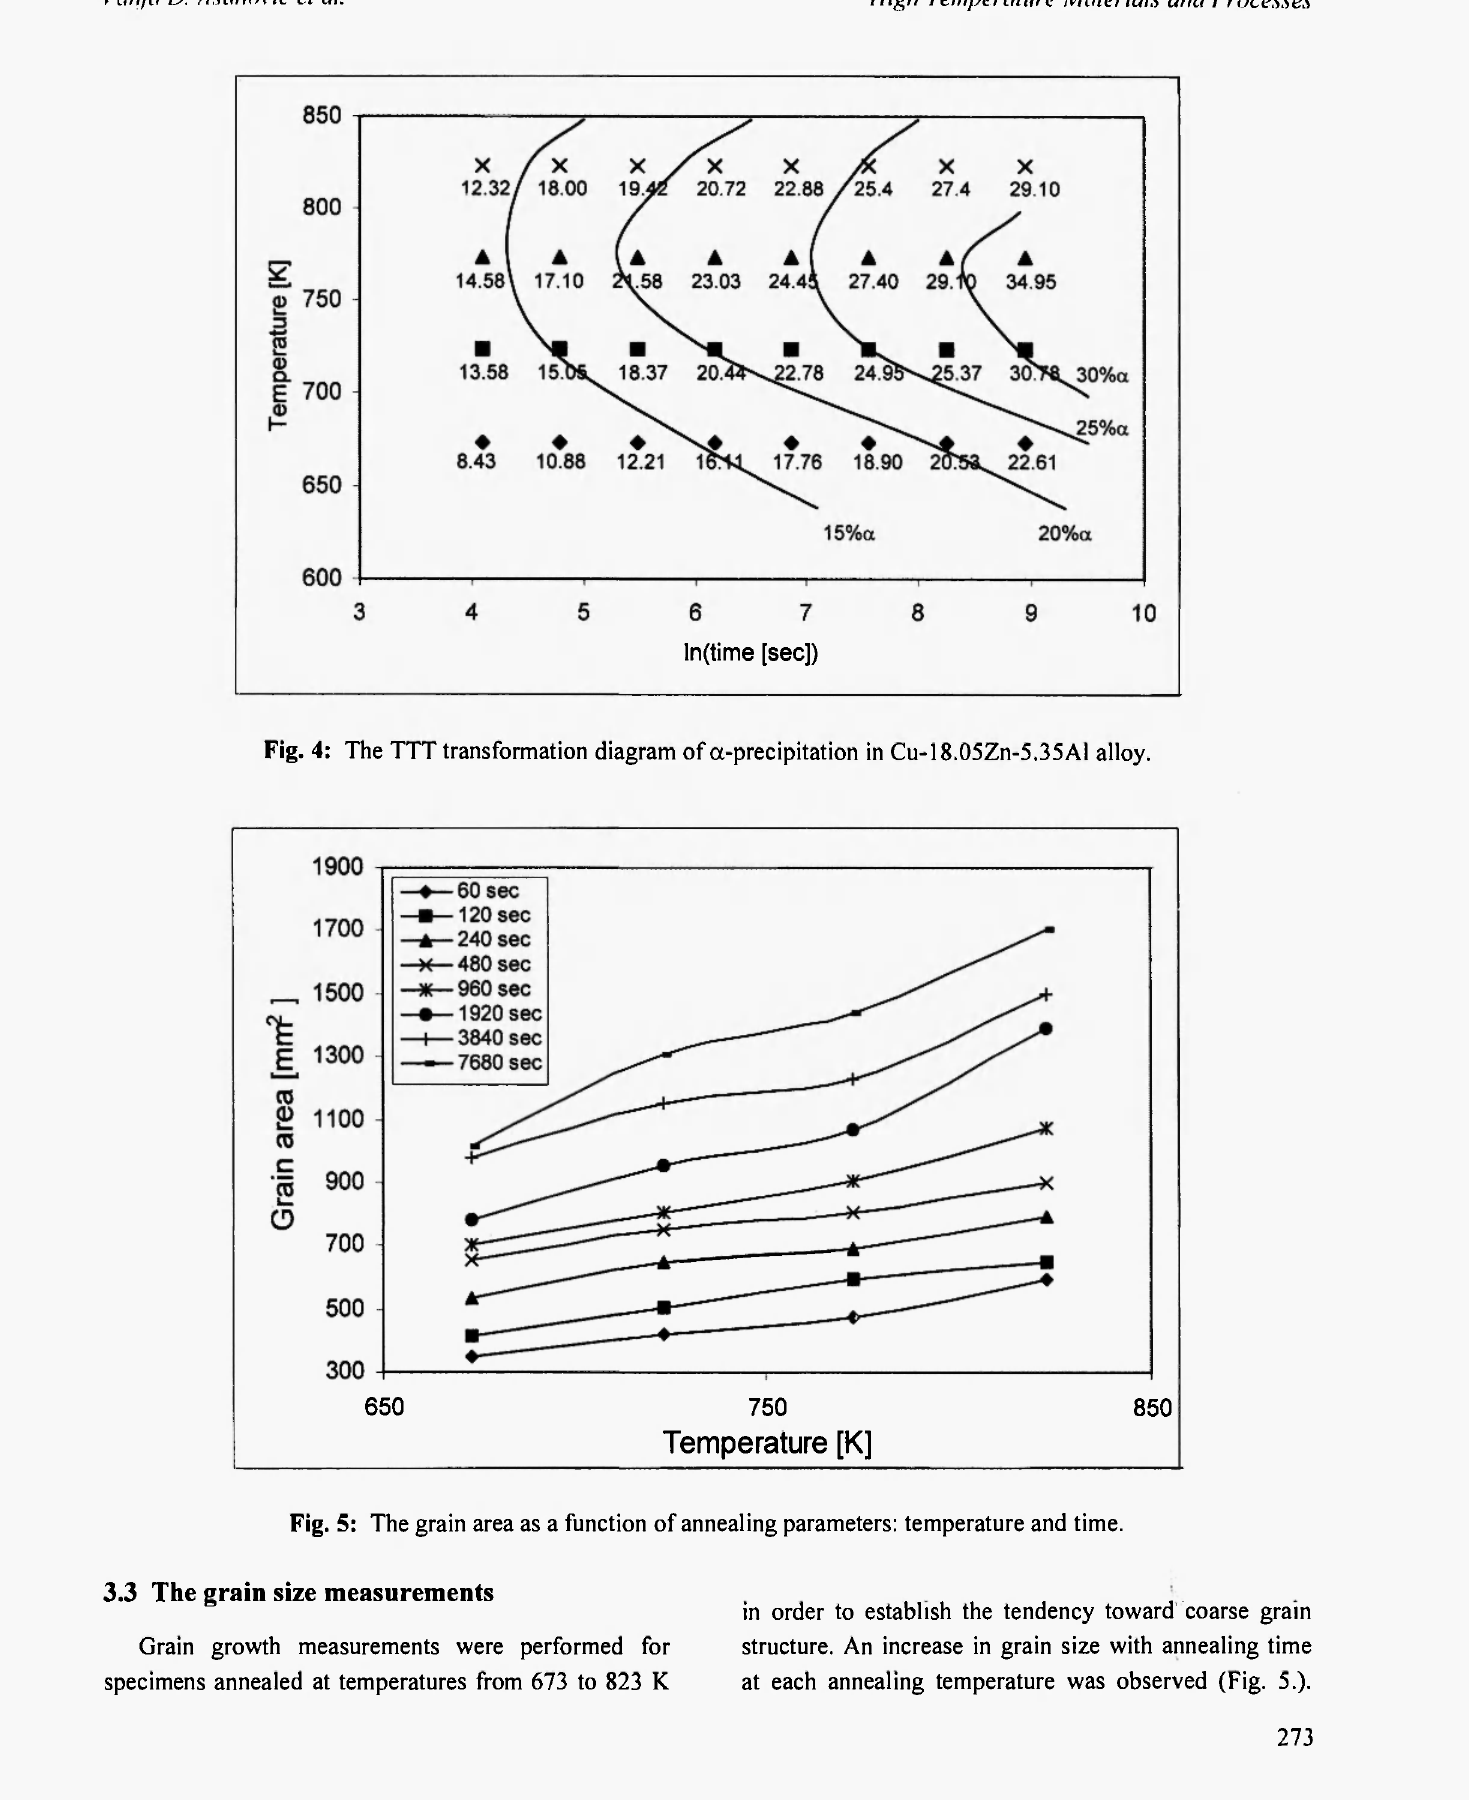
Fig. 5: The grain area as a function of annealing parameters: temperature and